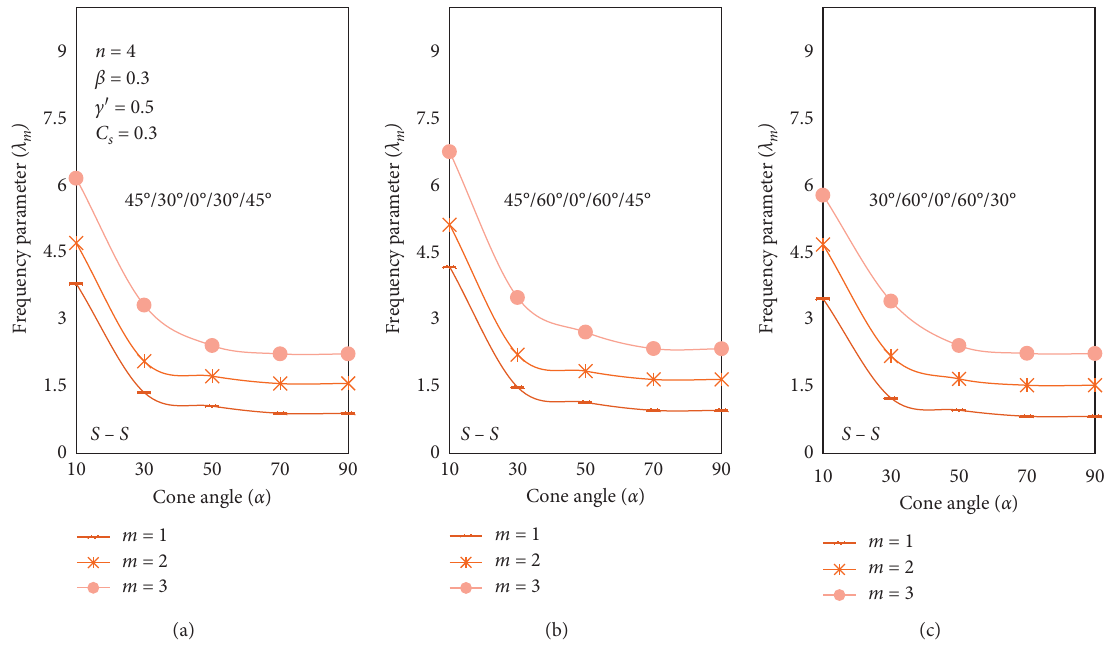
Figure 5: Influence of cone angle on the frequency parameter of five-layered conical shells with KE/EGE/GE/EGE/GE material